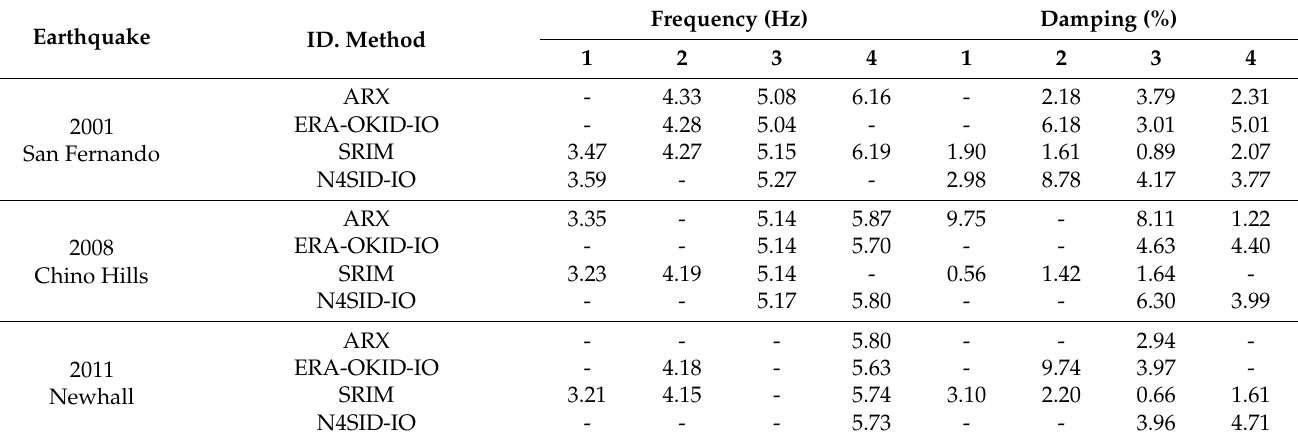
Table 7. Channels 9~17 of the dam foundation as a non-uniform input, the record of observation channels 1~8 of the dam body as the output, and the system identification results of frequency and